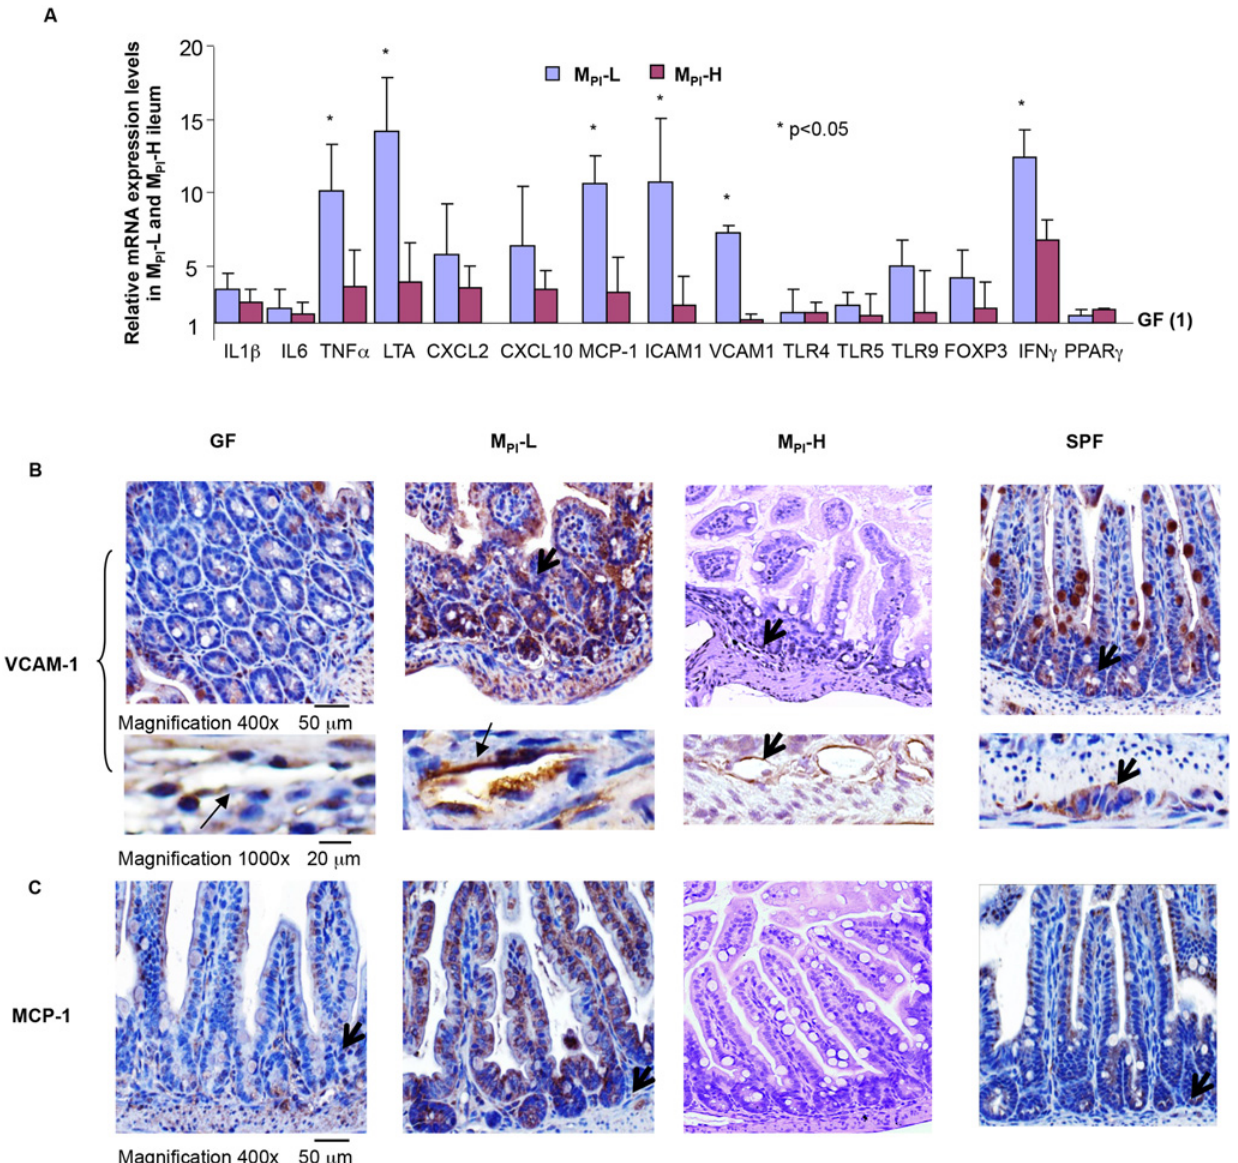
Fig 4. Differential expression of innate immune/inflammatory response-related genes in M PI -L,-H by qRT-PCR and immunohistochemistry. A: Ileum RNAs were extracted from preweaned GF (n = 3), M PI -L (n = 5) and M PI -H (n = 5) gnotobiotic mice. M PI -dependent gene expression levels were normalized to GAPDH and expressed as fold change over GF (designated as 1). B: The NF- κ B-target gene VCAM1 was analyzed by immunohistochemical staining of 5 micron paraffin-embedded distal ileum tissue from preweaned GF, M PI -L,-H-gnotobiotic and SPF mice (n = 3/per group) using anti- VCAM1 respectively. Representative areas are shown (magnification 400x), black arrows indicate VCAM-1 expression in ileal epithelium and endothelial cells. C: MCP-1 expression was analyzed by immunohistochemical staining of 5 micron paraffin-embedded distal ileum tissue from 3wk-old GF,M PI -L,-H and SPF mice (n = 3/per group) using anti- MCP-1 respectively. Representative areas (n = 3/per group) are shown (magnification 400x), black arrows indicate MCP-1 expression in ileal